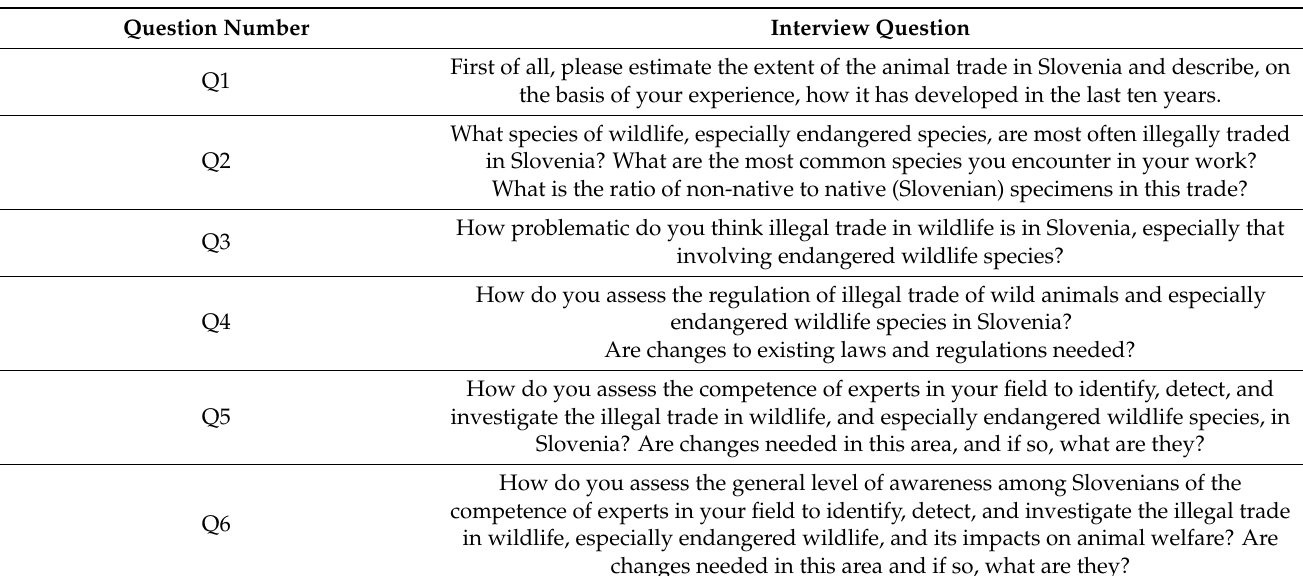
Table 1. Semi-structured interview